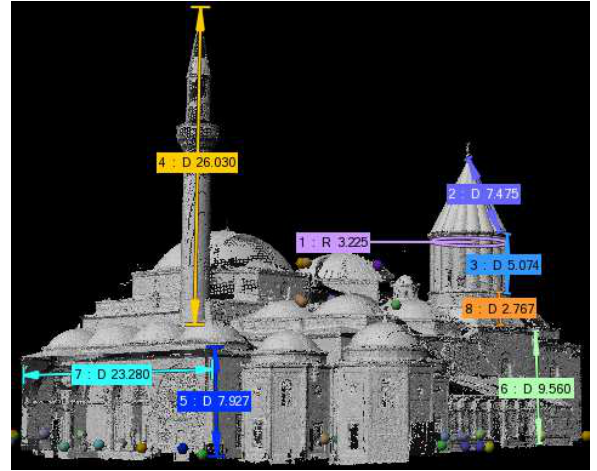
Figure 9. Dimensions of outside details (units are